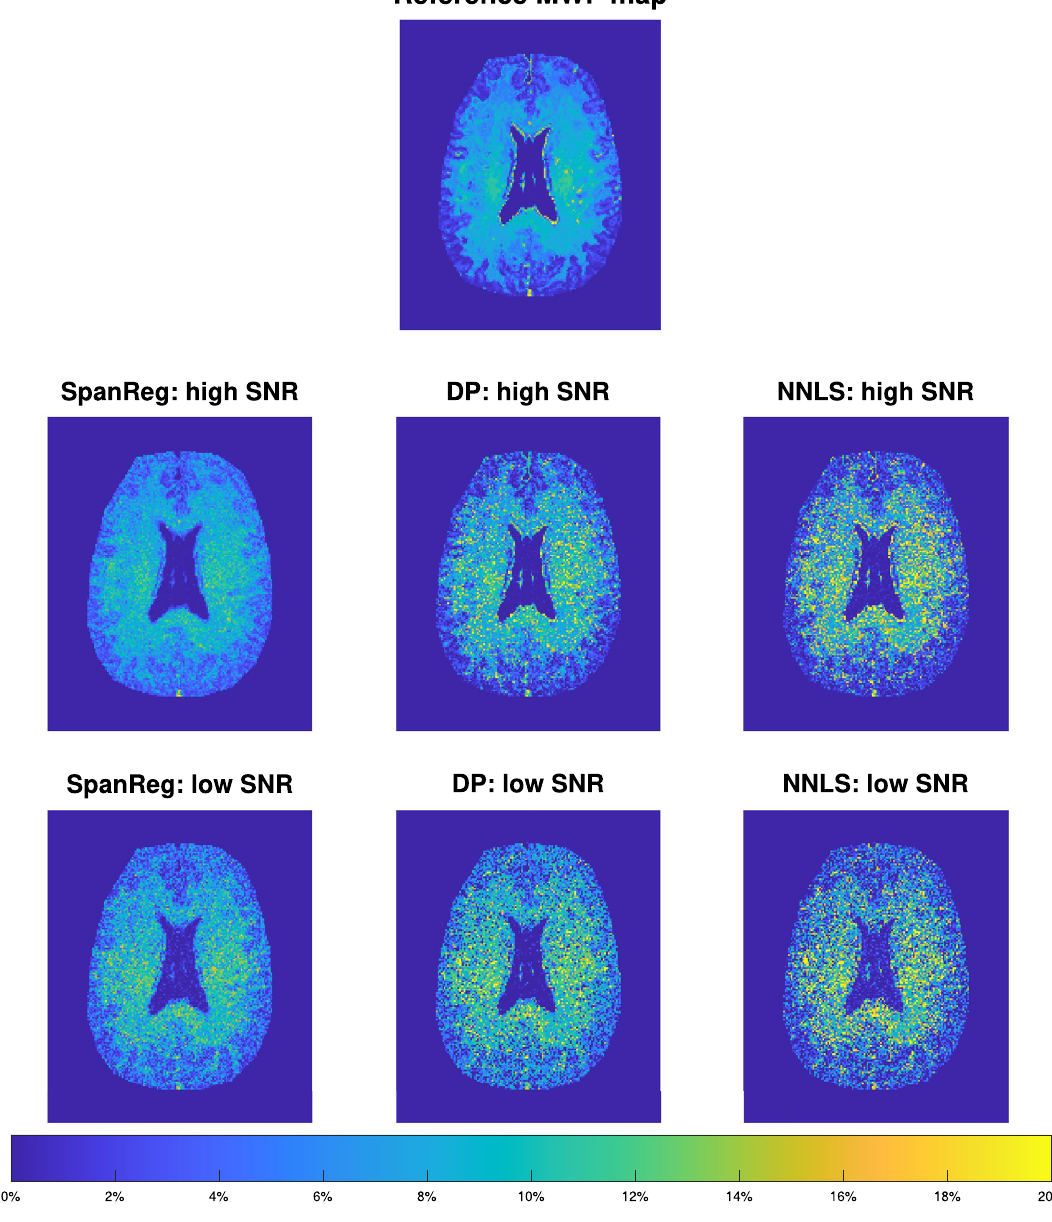
Figure 5. Uppermost image: reference MWF map; MWF maps generated from high SNR (top row; SNR = 800) and low SNR (bottom row; SNR = 200) data using SpanReg, NNLS with the DP, and non-regularized